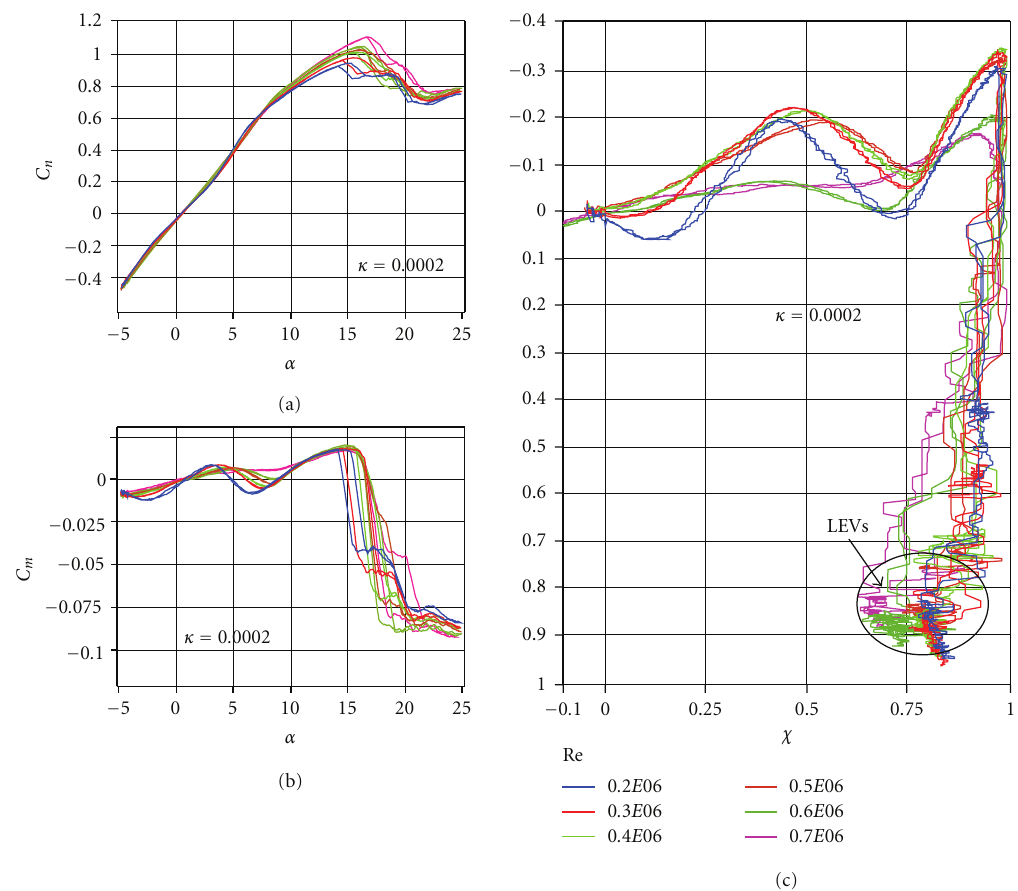
Figure 16: (a) C n versus α , (b) C m versus α , (c) x − γ cross plot; at κ = 0 . 0002 for varied Re = 0 . 2 E 06 to 0 . 7 E